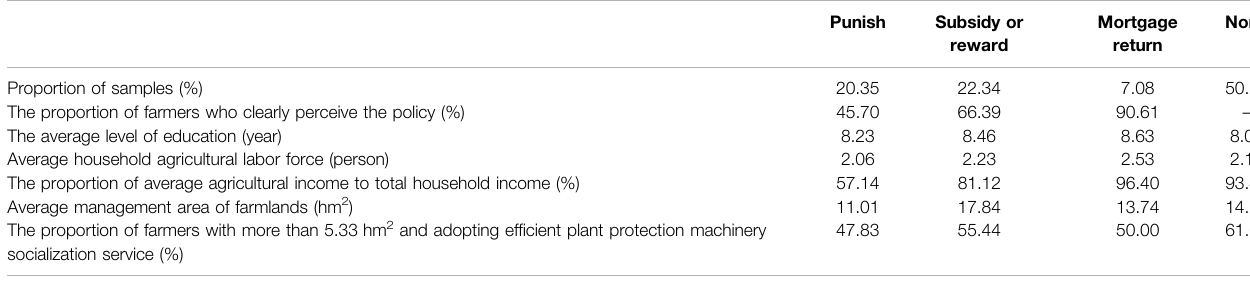
TABLE 5 | Basic characteristics of farmers in different policy application areas.